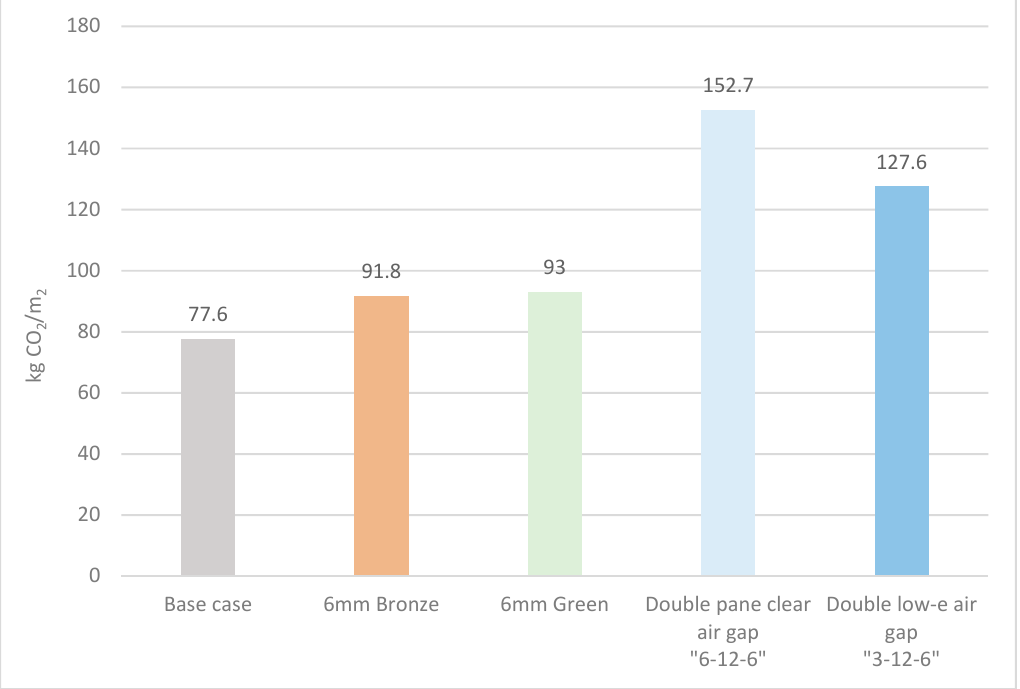
Figure A2. CO 2 emissions from the material manufacturing for the transparent alternatives.